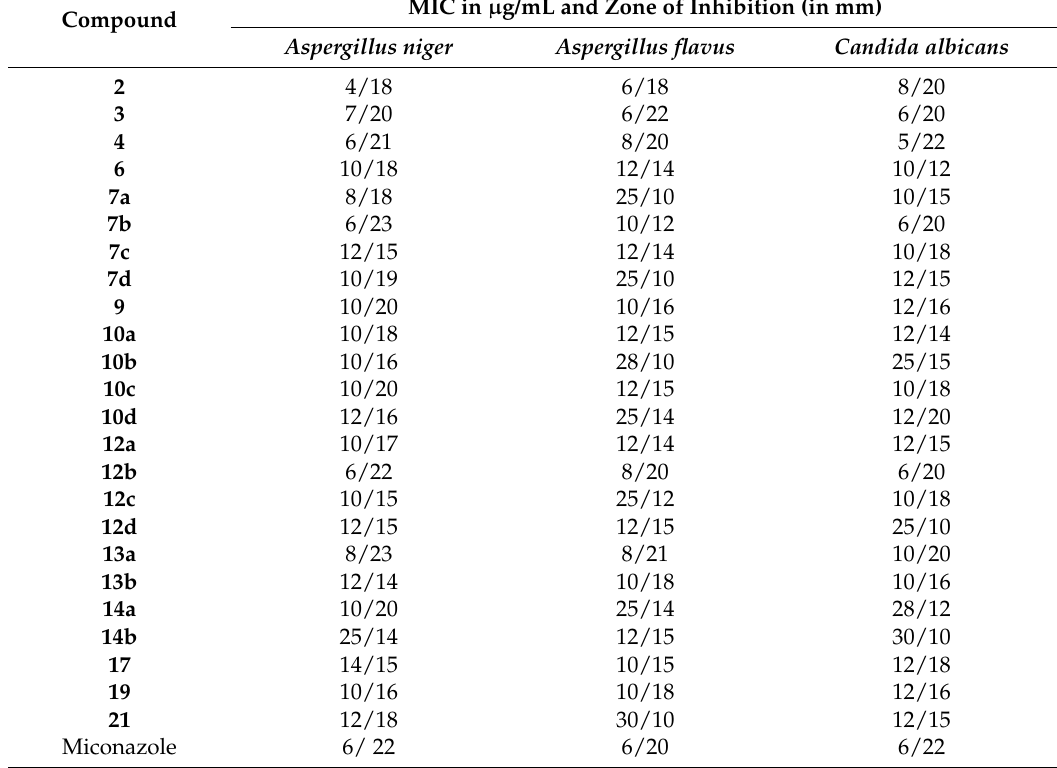
Table 3. Antifungal activity of newly synthesized